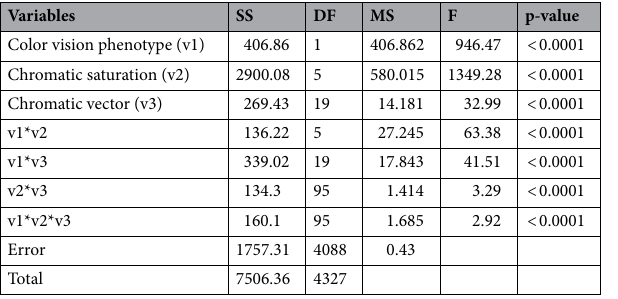
Table 2. Results of the three-way ANOVA on the number of errors during the perceptual task. SS sum of squares, DF degrees of freedom, MS mean square.